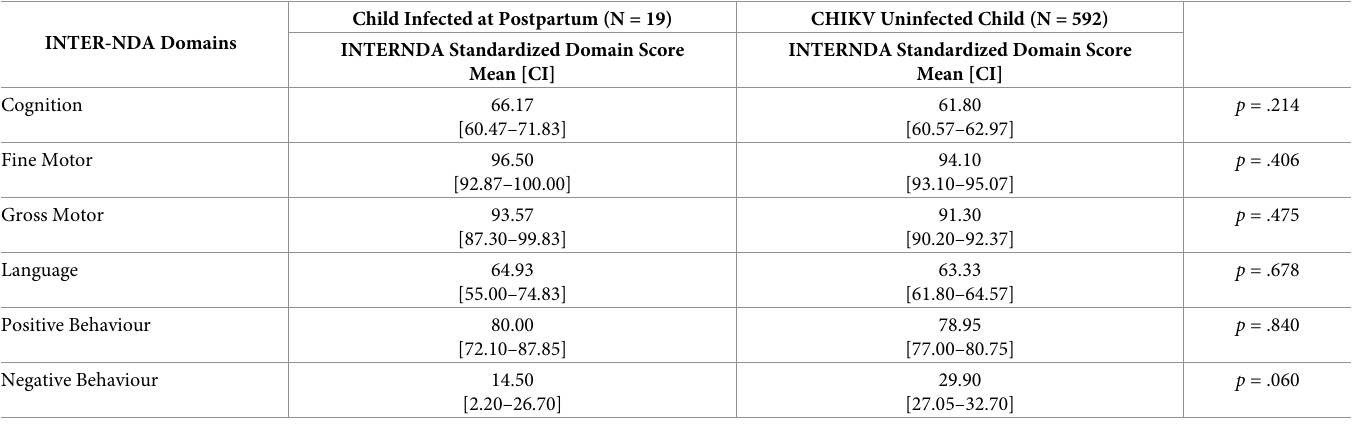
Table 8. Mean differences on standardized INTER-NDA domain scores between children infected with CHIKV postpartum vs. CHIKV uninfected children. INTER-NDA